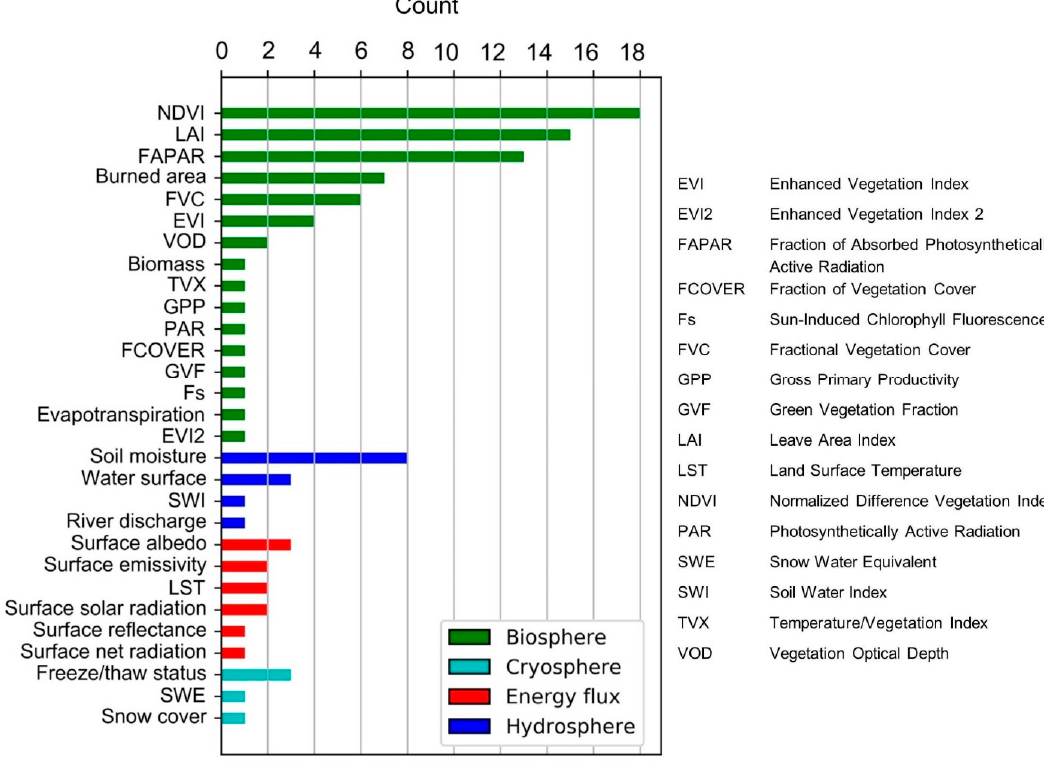
Figure 5. Sensors used for time-series generation in this review. Full sensor names can be found in Table A1.